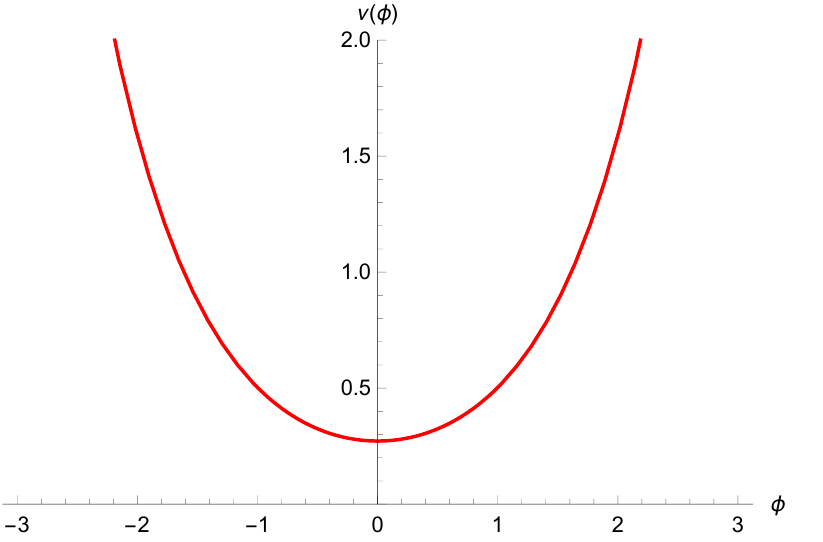
Figure 10. The polymer trajectory of the volume in ( v , ˜ c ) for the flat FLRW Universe. The volume presents a minimum, showing that a Big Bounce takes